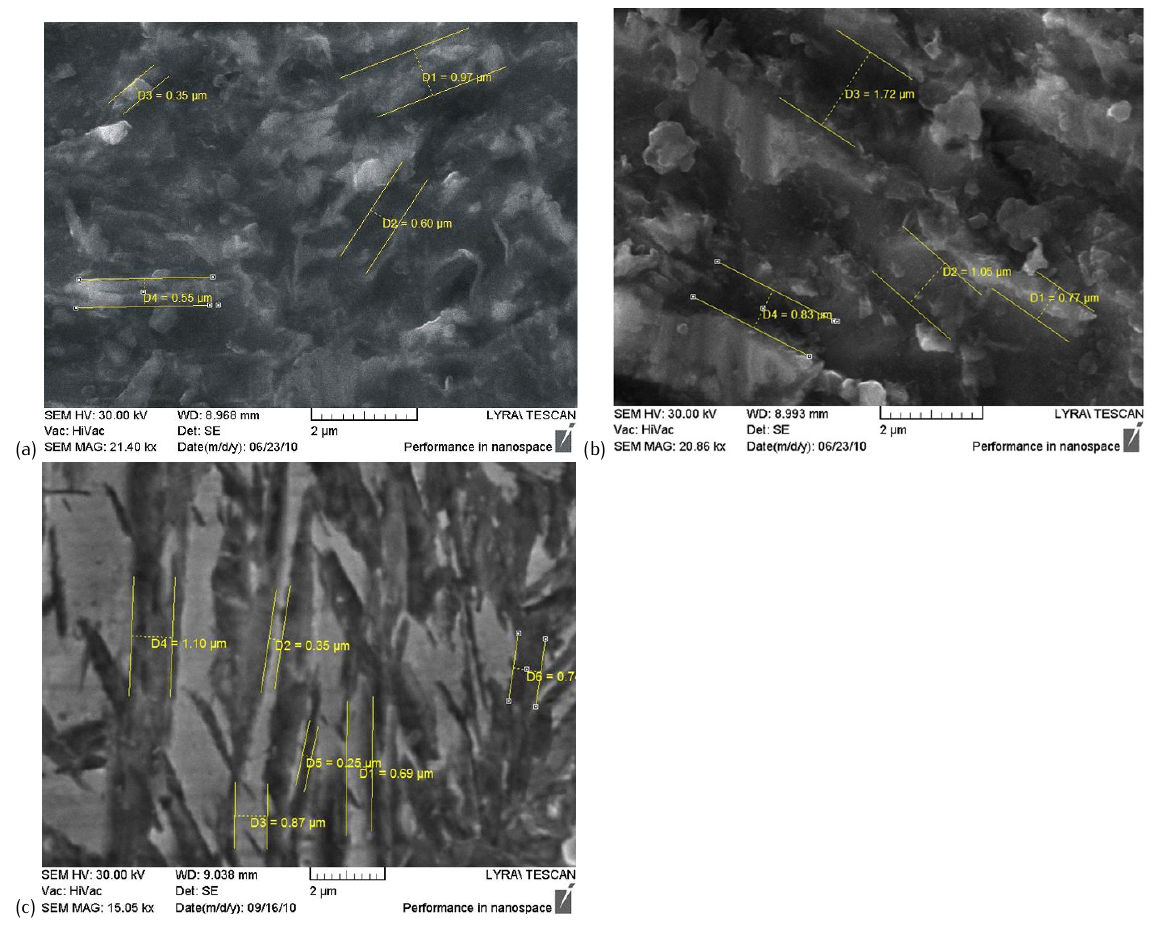
Figure 6. Sizes of micro structural elements: (a) 18Cr2Ni4A - granulated steel, (b) 18Cr2Ni4WA - air cooling, (c) 18Cr2Ni4WA - immediately